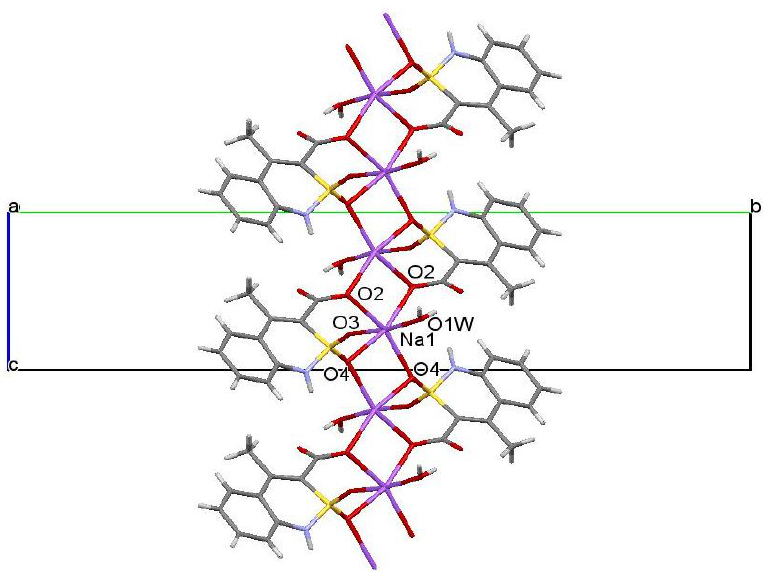
Figure 4. Packing of Sodium salt monohydrate 3 in the crystal phase. Projection along [1 0 0] crystallographic direction.